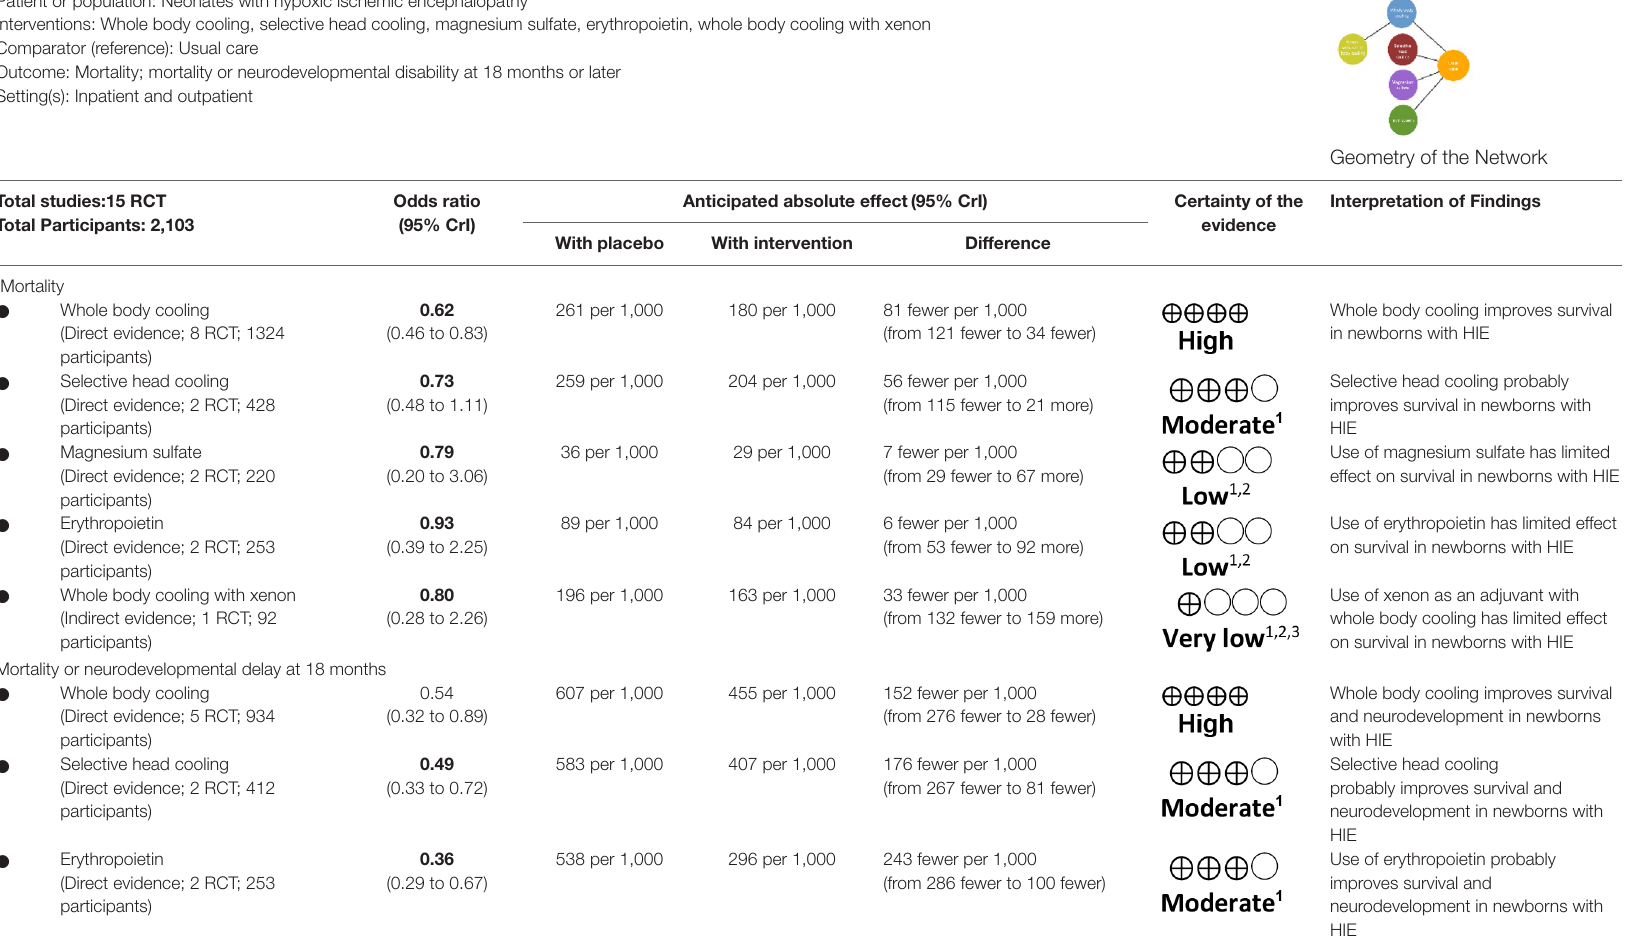
TABLE 3 | Summary of findings table for the primary outcomes assessed in this study. Estimates of effects, credible intervals, and certainty of the evidence for comparison of neuroprotective therapies for neonates with hypoxic ischemic encaphalopathy Patient or population: Neonates with hypoxic ischemic encephalopathy Interventions: Whole body cooling, selective head cooling, magnesium sulfate, erythropoietin, whole body cooling with xenon Comparator (reference): Usual care Outcome: Mortality; mortality or neurodevelopmental disability at 18 months or